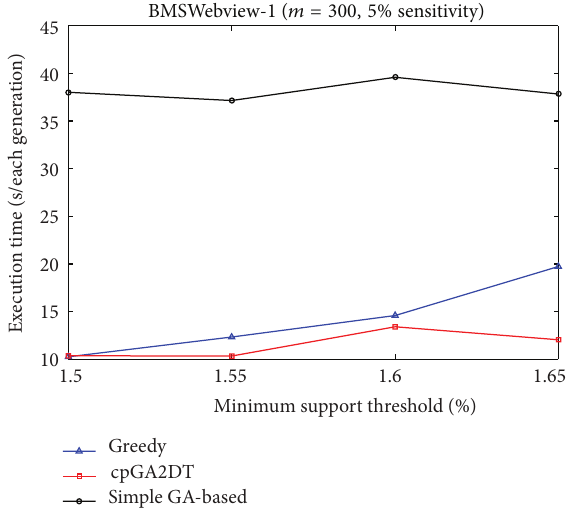
Figure 9: Comparisons of execution time at various sensitivity percentages for BMSWebview-2 database.